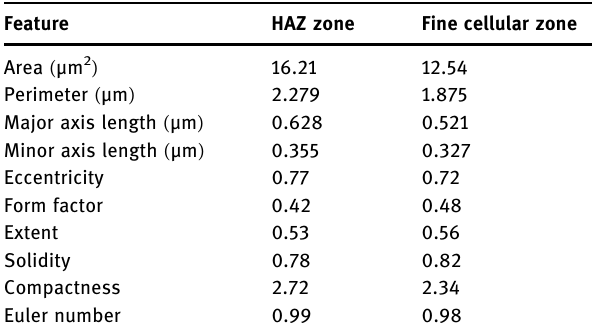
Table 2: Mean feature values of cells in HAZ and fi ne cellular zones Feature